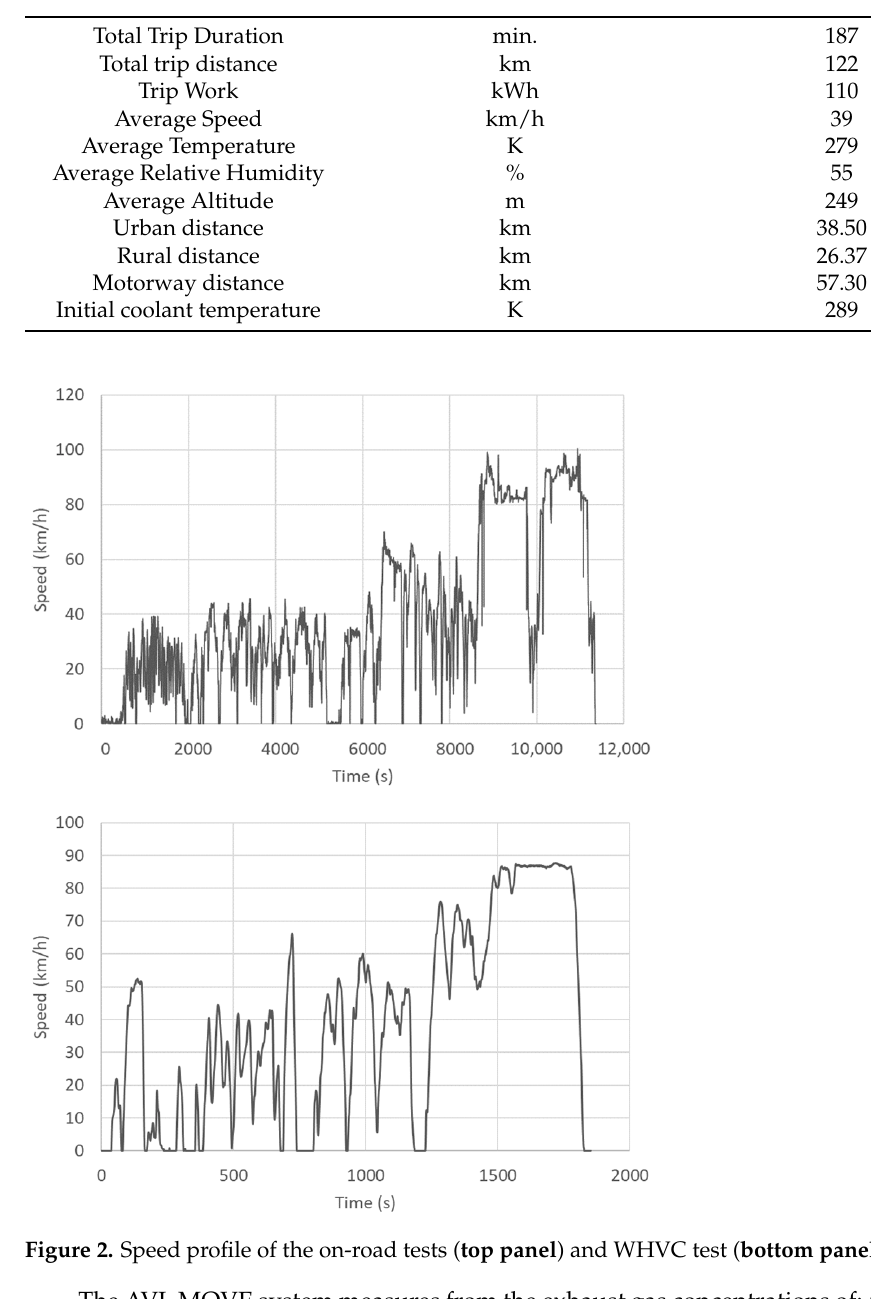
Table 2. Route characteristics.